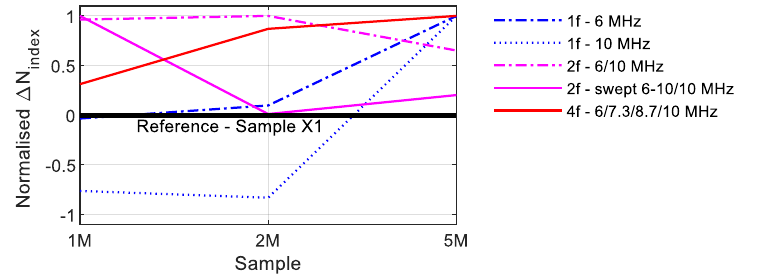
Figure 25. Comparison N index values.